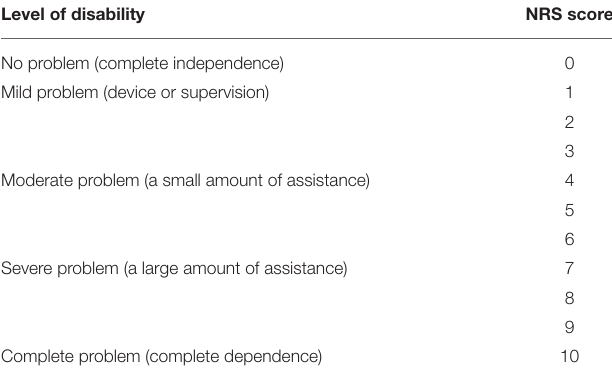
FIGURE 1 | Numeric rating scale (NRS). TABLE 2 | The NRS of